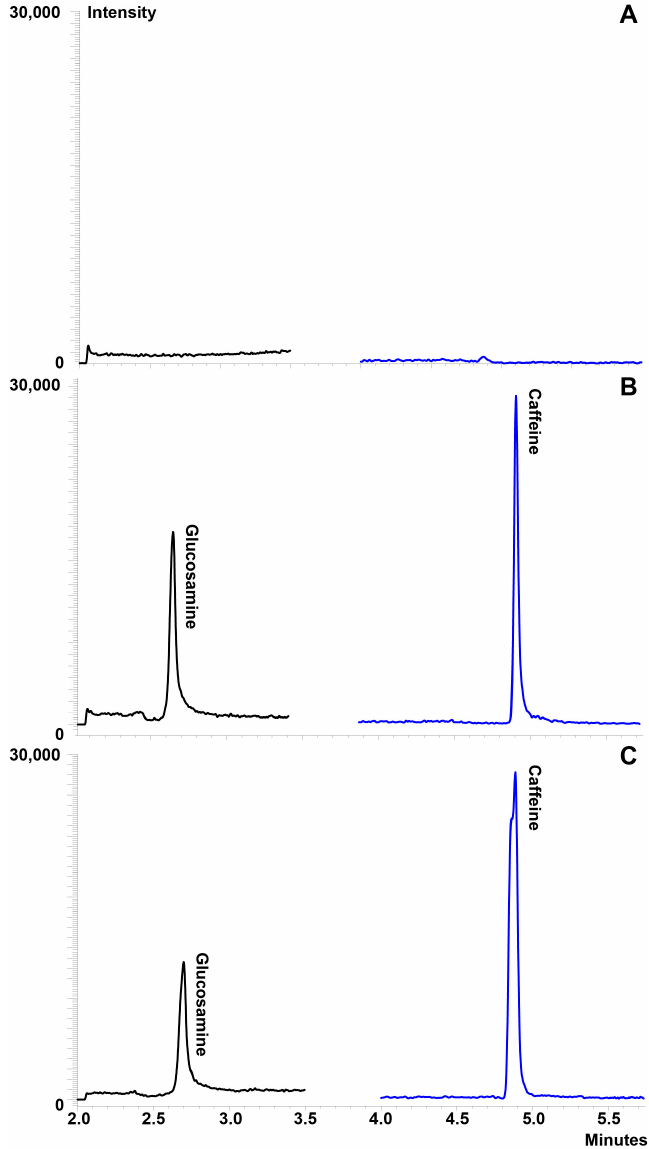
Figure 2. Representative chromatograms of glucosamine in serum: ( A ) blank serum demonstrating no interfering peaks co-eluted with the compounds of interest; ( B ) serum containing glucosamine and the internal standard at glucosamine at 10 µ g/mL; and ( C ) pharmacokinetic sample at 2 h post-dose (450 mg glucosamine HCl via administration of one Phycox ® soft chew).